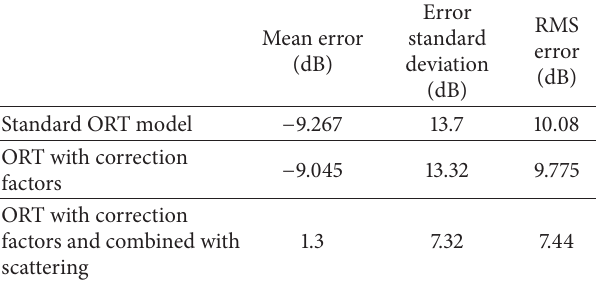
Table 3: Comparison between results with different ORT models (site